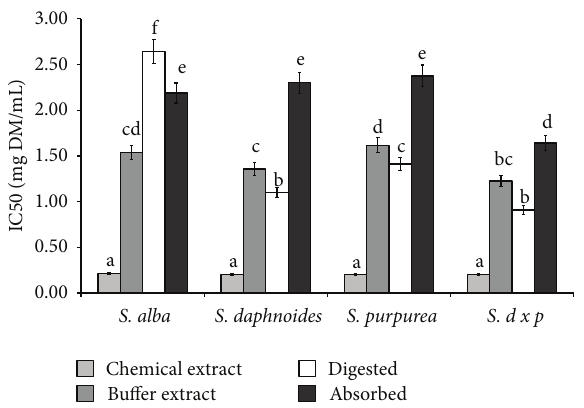
Figure 6: Effect of extraction system on XO-inhibitory activity of phytochemicals from bark of different Salix genotype. Bars (means) followed by the different letters differ significantly (Tukey-test, 𝑃 < 0.05